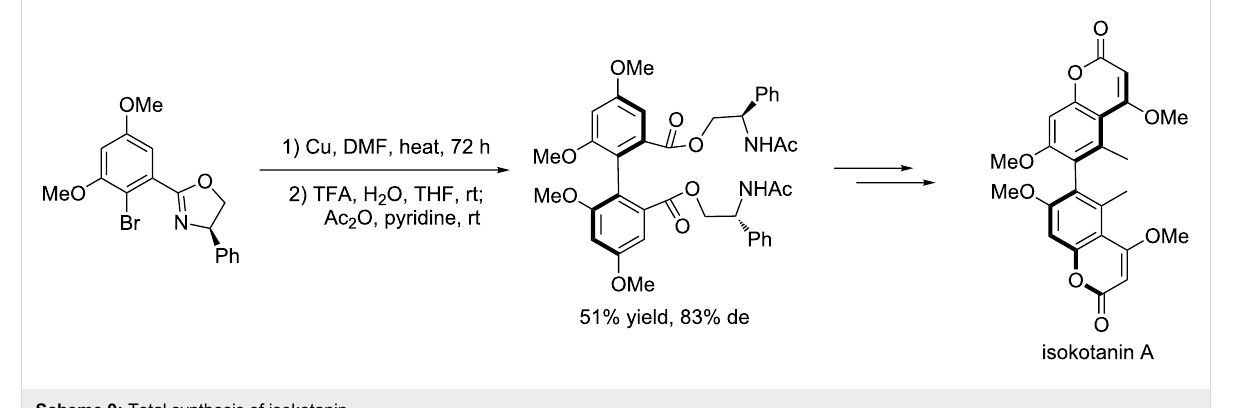
Scheme 9: Total synthesis of isokotanin.